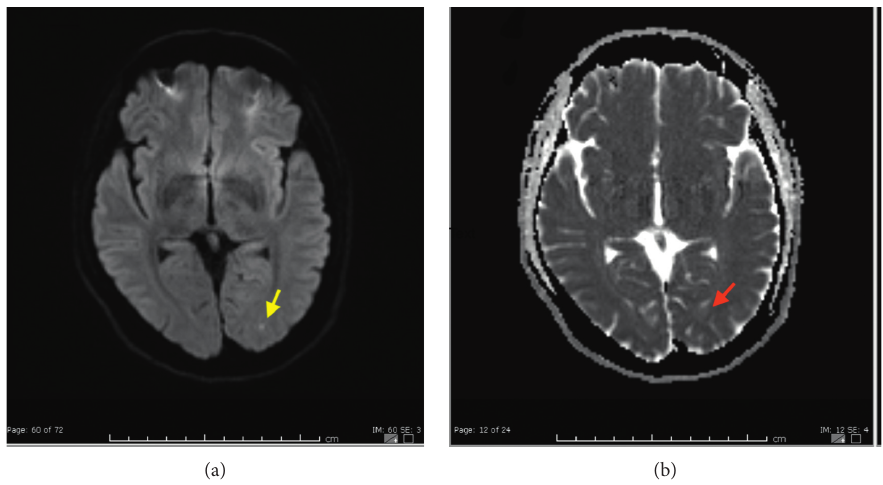
Figure 1: (a) Diffusion-weighted imaging (DWI) MRI head showing a tiny occipital subcortical hyperintense lesion. (b) The same lesion appearing faintly hypodense on apparent diffusion coefficient (ADC) MRI head. These findings of diffusion restriction were keeping with acute to early subacute lacunar infarction. Notably, these findings were not present on the new MRI done in the third admission (index admission).